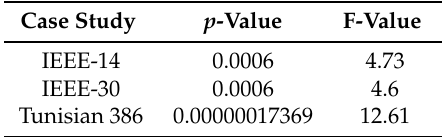
Table 9. Analysis report of the CSA, PSO, ALO and WOA for the different